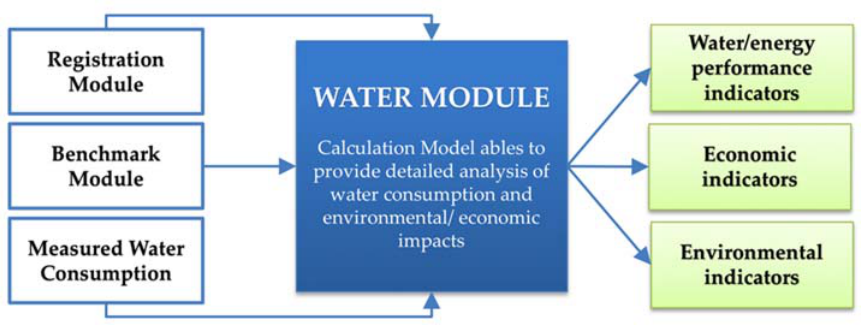
Figure 1. Methodology flow chart: WM input and output